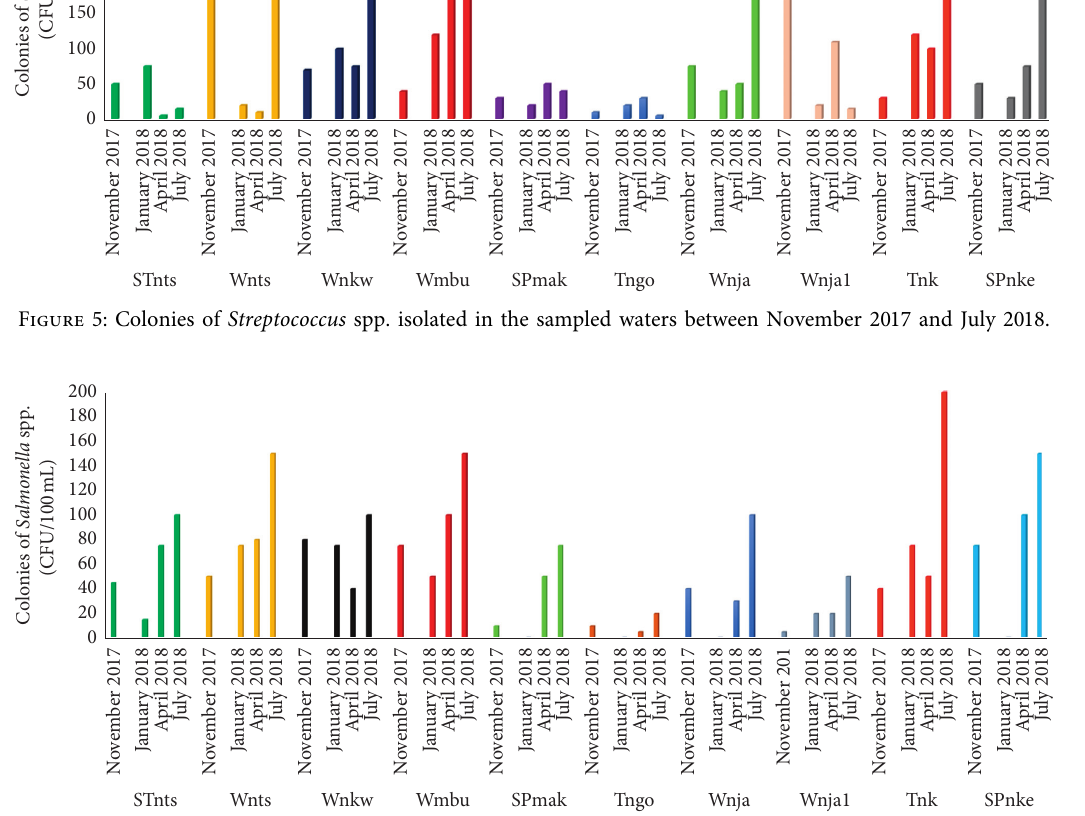
Figure 6: Colonies of Salmonella spp. isolated in the sampled waters between November 2017 and July 2018.